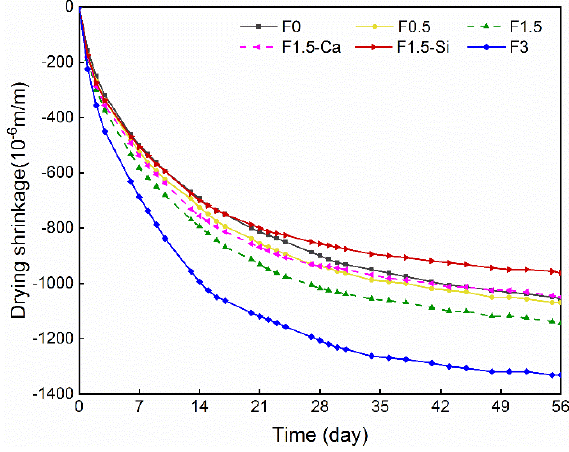
Figure 10. Drying shrinkage of LWAC with coir fibers of various contents and different treatments measured in 56 days.